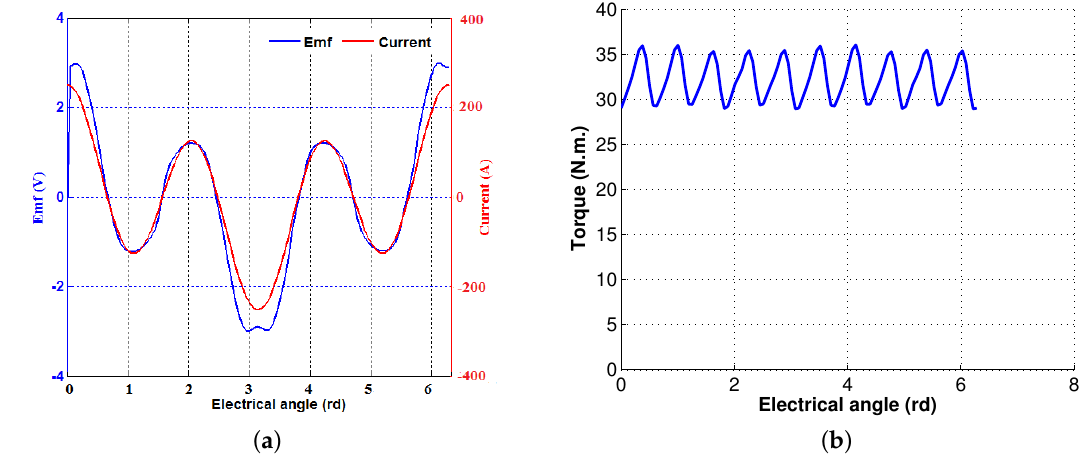
Figure 4. ( a ) Emf and current; ( b ) rated torque resulting from the interaction between emf and